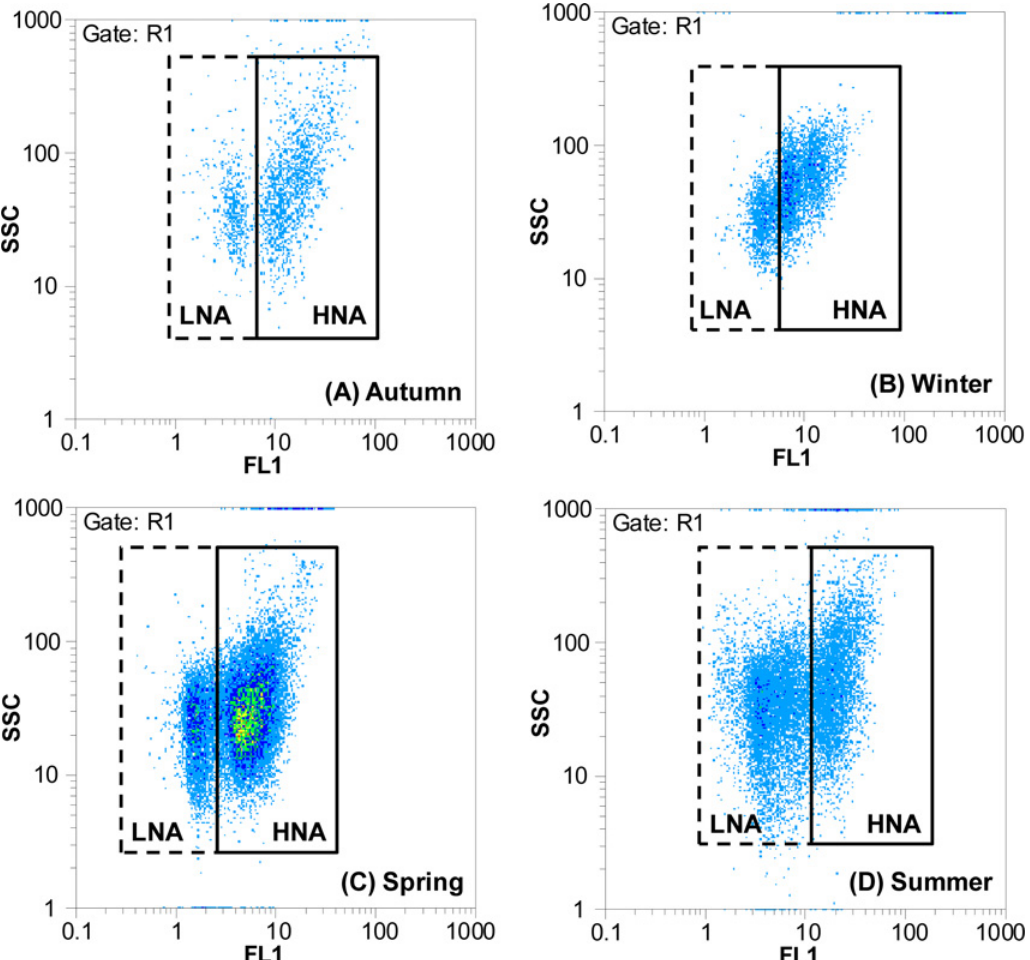
Fig 2. Flow cytogram example of LNA and HNA bacteria in the Haihe River. Dashed lines indicate LNA bacteria, and solid lines indicate HNA